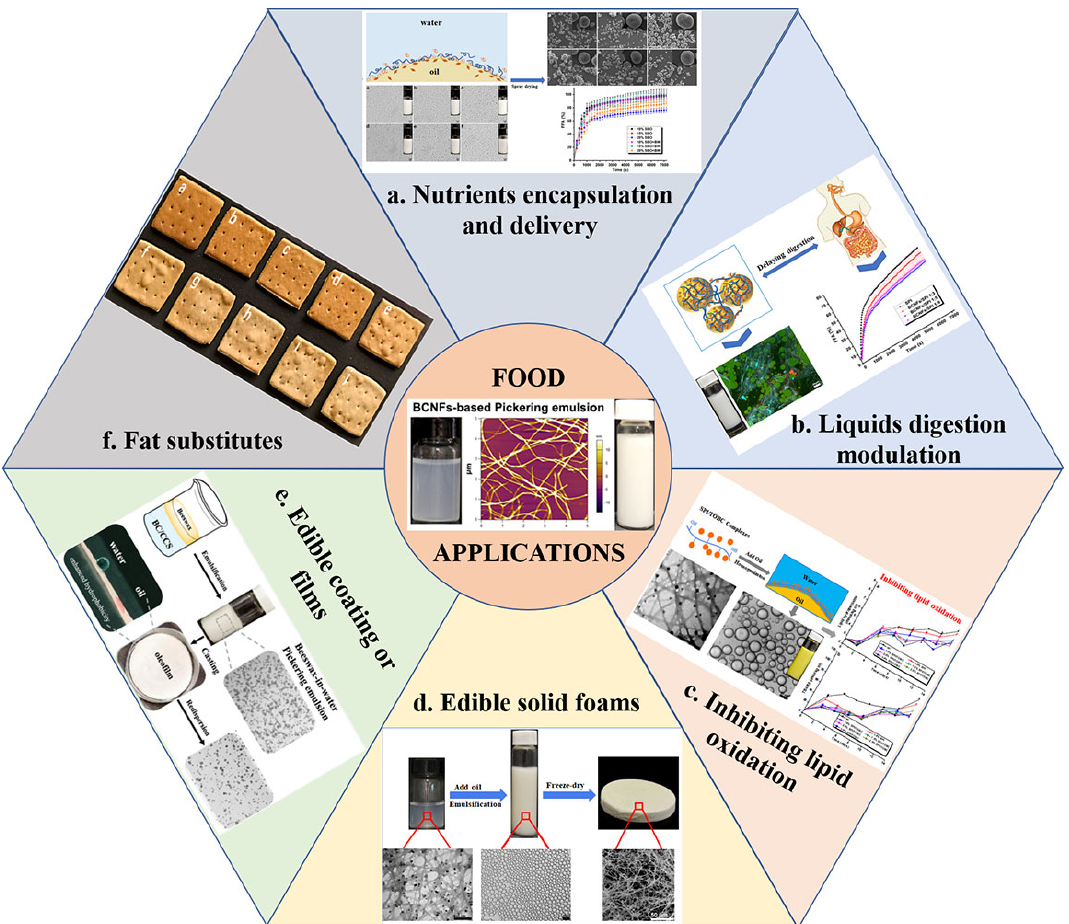
Figure 5. Overview of the applications of O/W Pickering emulsions stabilized by BCNF-based particles: ( a ) Nutrient encapsulation and delivery. Reprinted with permission from [57]. Copyright (2022), Elsevier. ( b ) Lipid digestion modulation. Reprinted with permission from [42]. Copyright (2022), Elsevier. ( c ) Inhibiting lipid oxidation. Reprinted with permission from [18]. Copyright (2019), Elsevier. ( d ) Edible solid foams. Reprinted with permission from [43]. Copyright (2020), Elsevier. ( e ) Edible coatings or films. Reprinted with permission from [58]. Copyright (2020), American Chemistry Society. ( f ) Fat substitutes. Reprinted with permission from [59]. Copyright (2021), Elsevier.